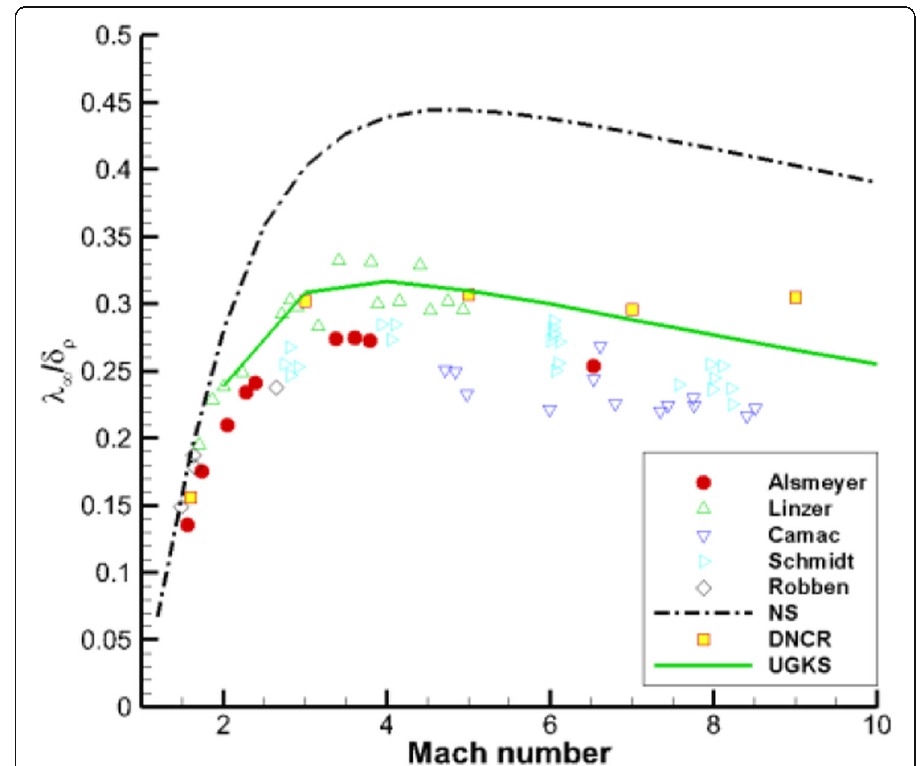
Fig. 6 Comparison of inverse density thickness with experimental data using DNCR